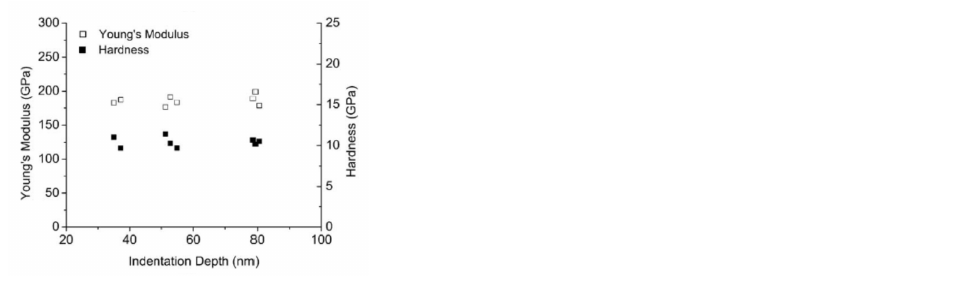
Figure 12. Hardness and Young’s modulus vs. indentation depth. Reproduced with permission from Ref. [63].